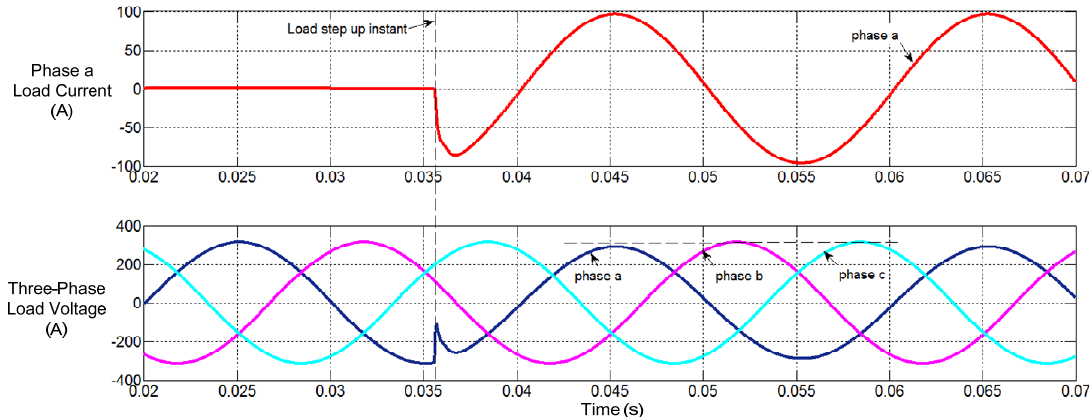
Figure 13. Simulation waveforms of the three phase load voltage (single-phase load step up): ( a ) No magnetic couples; ( b ) With magnetic couples; ( c ) IPSC locus of load voltage with magnetic